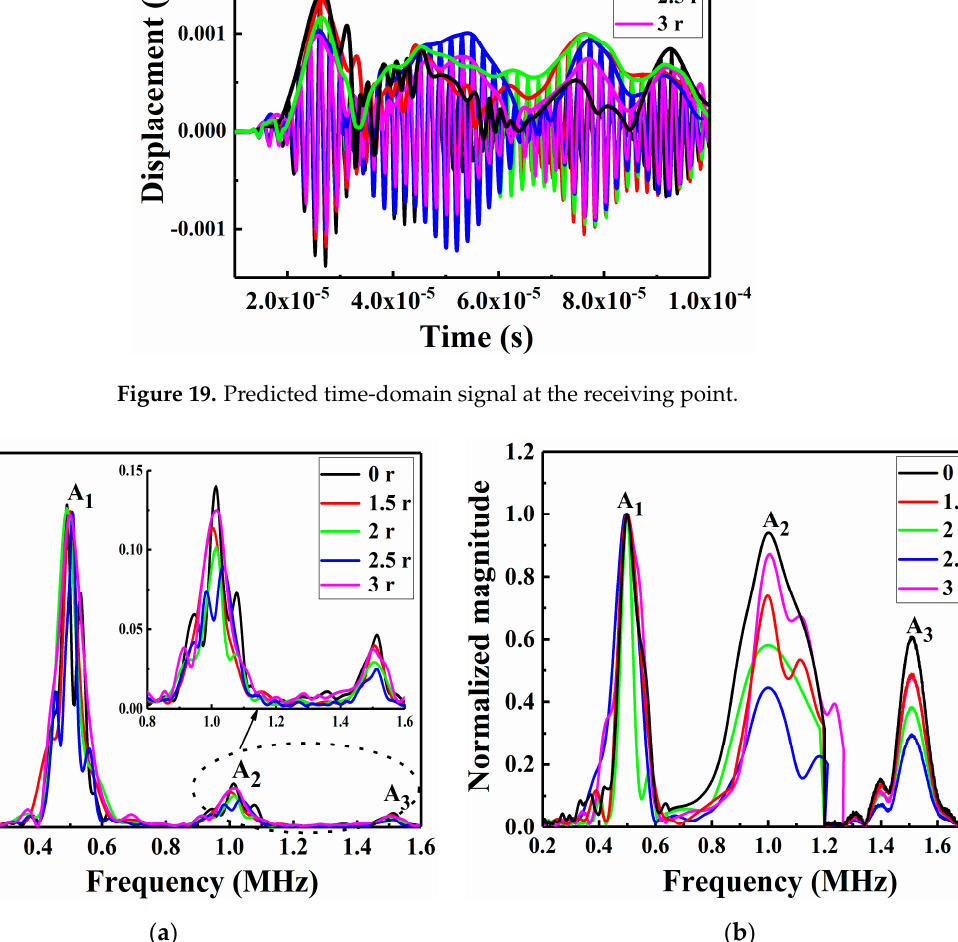
Figure 21. Numerical and experimental curves of the CFRP laminates repaired with patches of various sizes: ( a ) second RANP and ( b ) third RANP. 5.5. Selection of the Optimal Patch Design The previous section discussed the effects of patches of various sizes on the CFRP laminate repair behaviors, and the specimen repaired with a patch of radius 2.5 r demon- strated a better impact resistance behavior than the other repaired specimens. Based on the obtained simulation results, a third-order polynomial interpolation method was es- tablished to predict the relationships between the patch radius R , absorbed energy E abs , delamination area E del , second RANP E sec , and third RANP E thi . The forms of the above polynomial interpolation variable equations are expressed as follows: 8177.60482.10709.00667.0 23 +−−= RRR Ε abs 5956.7110436.694911.34819.2 23 +−+= RRR Ε del